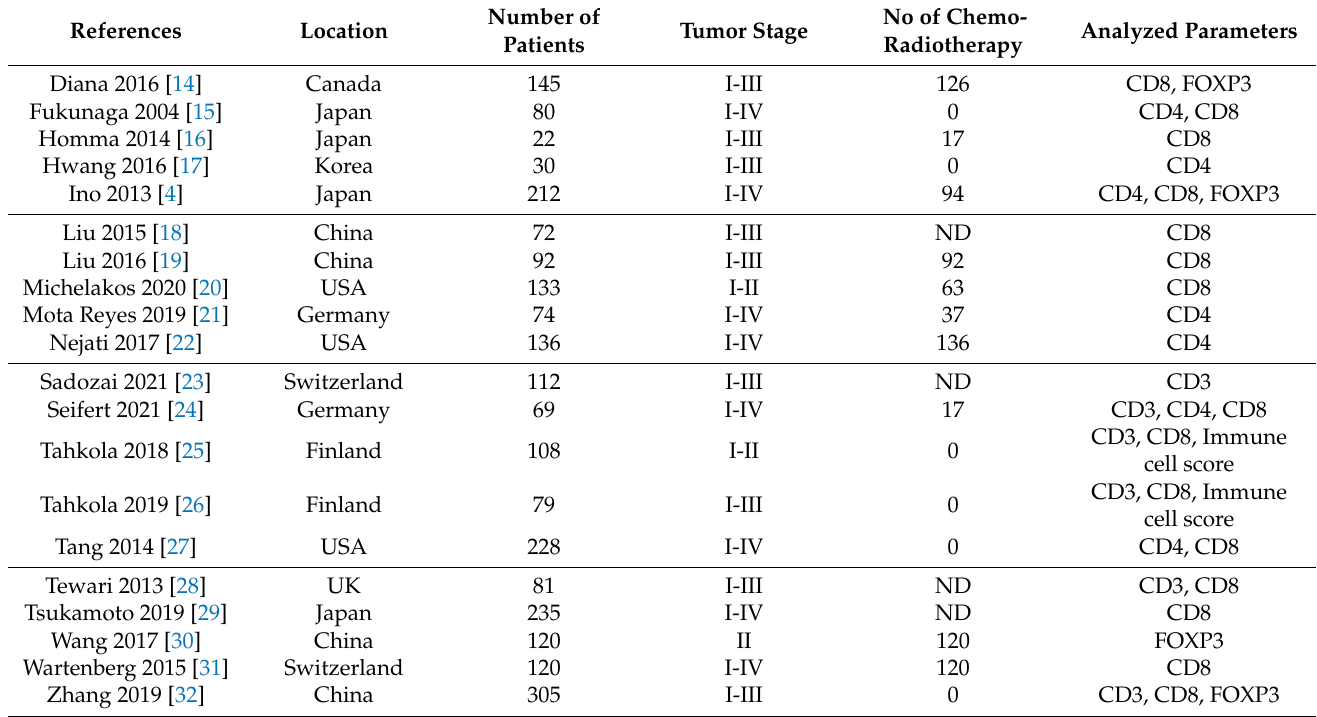
Table 1. Main characteristics of the eligible studies.